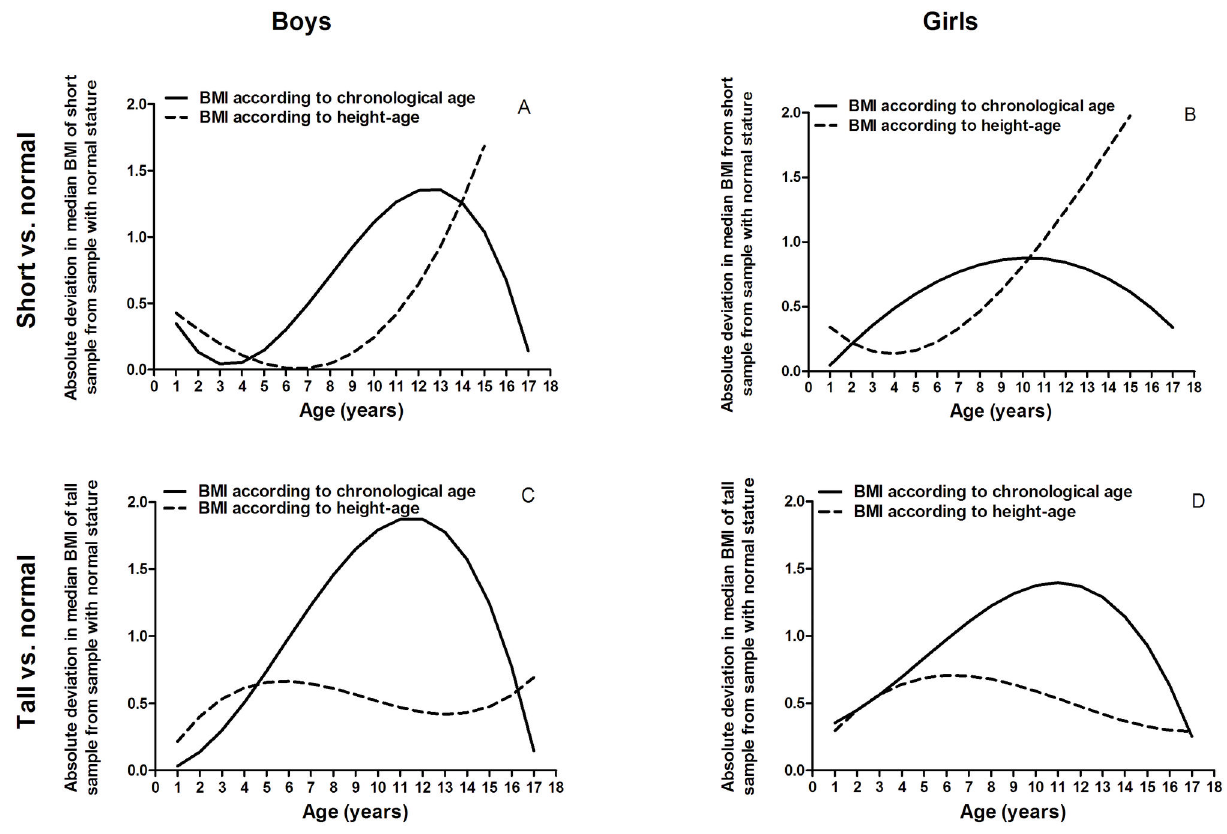
Figure 2. Absolute deviation in median BMI-for-chronological-age and BMI-for-height-age between samples with tall or short stature from the sample with normal stature. A smaller deviation indicates that the median BMI of short or tall sample is more similar to the median BMI of the sample with normal stature. For boys with a short stature in the ages 4 up to 14 years of age, expressing BMI according to height-age resulted in a smaller deviation from the BMI distribution of children with a normal stature than when expressing BMI to chronological age, whereas in boys with a tall stature this was true in the ages 4-16 years. In girls, expressing BMI to height-age resulted in a smaller deviation in the ages 2-10 years if of being short stature and in the ages 2-17 years when being